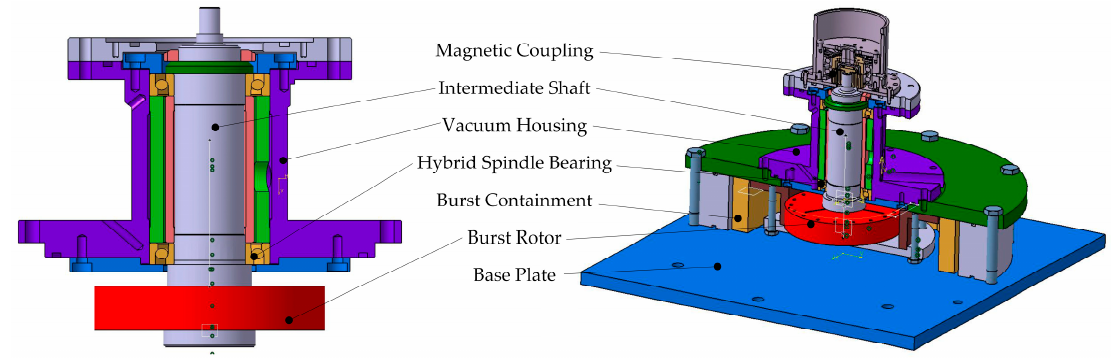
Figure 5. Initial test rig design intended to allow under-critical rotor operation.